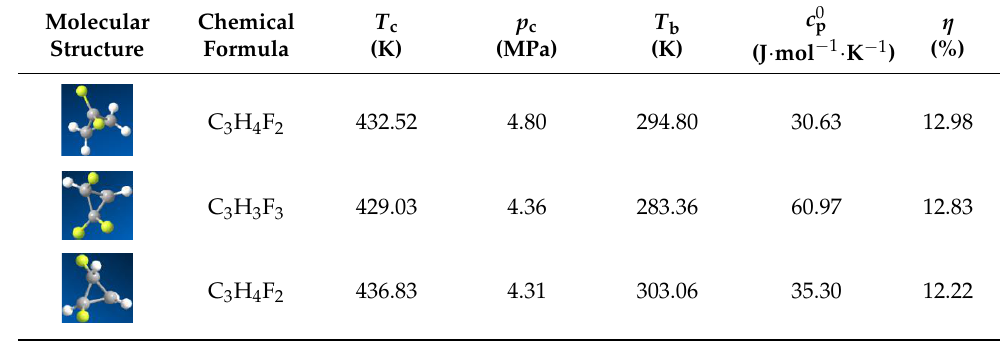
Table 10. Thermophysical properties and thermal efficiency of candidates at 473.15 K heat source. Molecular Structure